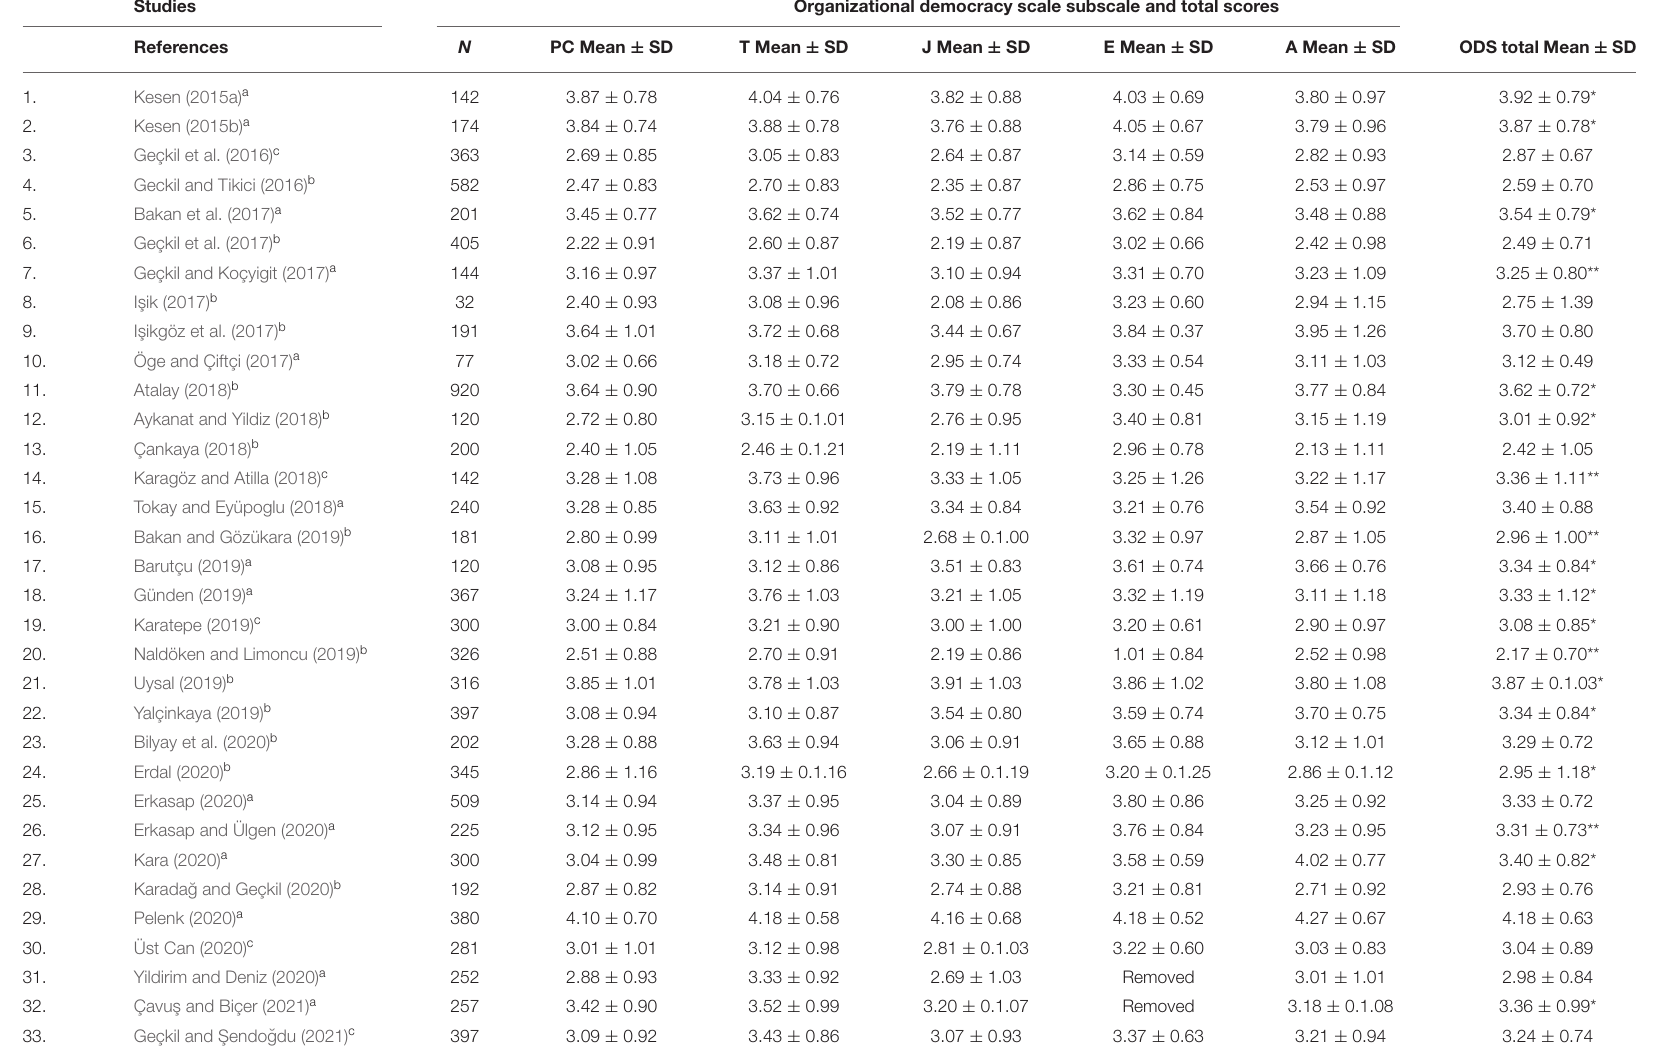
TABLE 1 | Organizational democracy scale total and subscale scores of participants ( N =